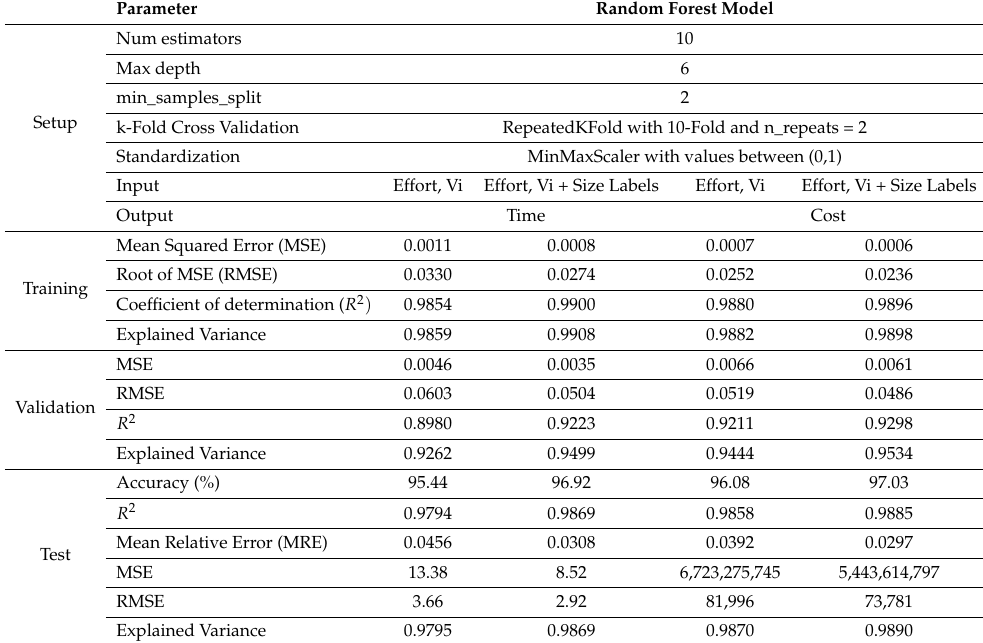
Table 10. Grouped results of RF algorithm for unlabeled and labeled data.